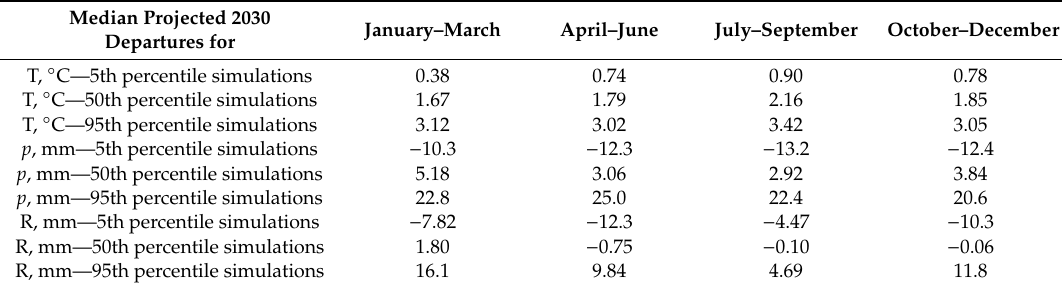
Table 2. Summary statistics for 214 climate simulations of projected 2030 departures in average monthly temperature (T), precipitation ( p ), and runo ff (R) by 5th, 50th, and 95th percentile models for each season, for the 374 National Park Service